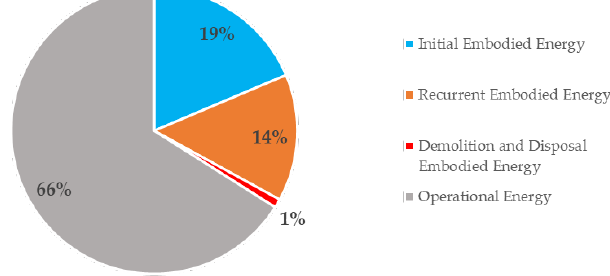
Figure 4. Life cycle energy of the case study building over 50 years.